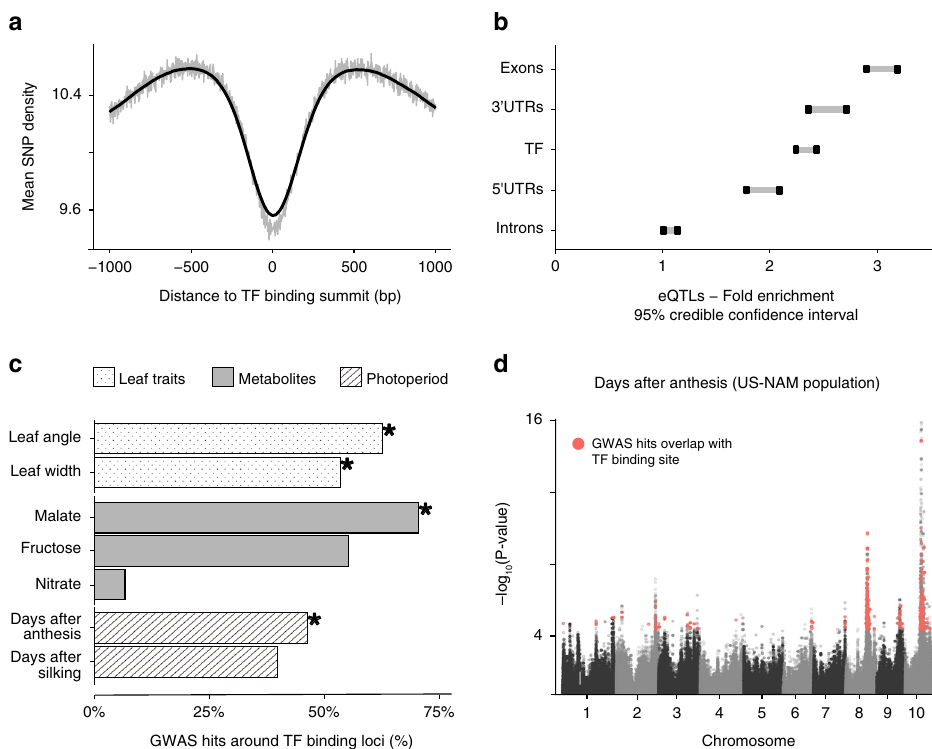
Fig. 3 TF-binding sites show low sequence diversity and enrichment in functional variation. a Distribution of the average SNP count in maize inbred lines around TF peaks (bin size: 100 bp). The smooth line corresponds to a sliding window of 100 positions to average the mean SNP counts. b 95% con fi dence interval for the enrichment of eQTLs from a previous study 21 vs. non-eQTLs SNPs, and relative to control regions for different sets of genomic regions (TF n = 144,890, exons n = 403,199, 3 ′ UTR n = 138,793, 5 ′ UTR n = 146,120, introns n = 151,414). c Proportion of phenotype-associated GWAS hits for an assortment of traits overlapping to TF-binding loci. Traits in which the enrichment was statistically signi fi cant (adj- P < 0.05) are labeled with an asterisk. d Manhattan plot of GWAS for days after anthesis. GWAS hits overlap with binding regions for a group of TFs previously associated with photoperiod variation are highlighted in red. Source data underlying Fig. 3c are provided in a Source Data fi